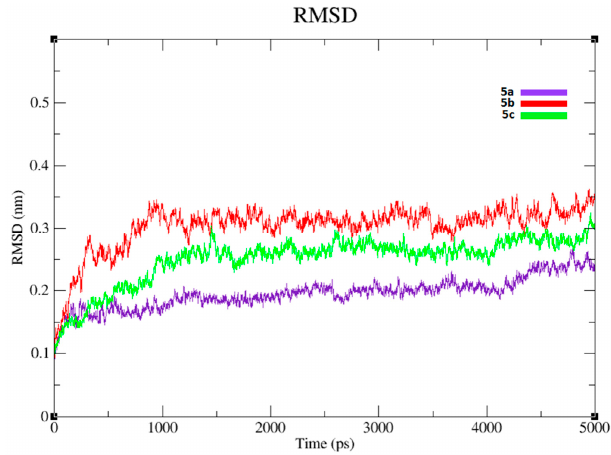
Figure 8. Root Mean Square Deviation (RMSD) graphs of ( 5a – c ) complexes at different time scale. The backbones with indigo, red and green represent ( 5a – c ) complexes, respectively.